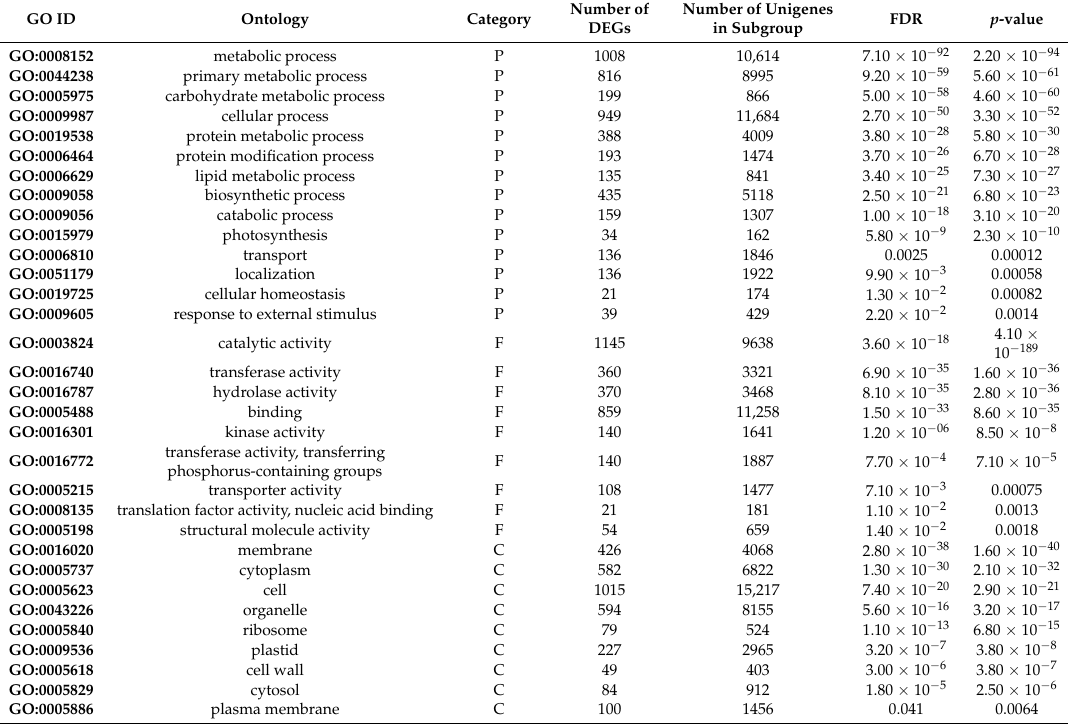
Table 3. Gene ontology (GO) functional enrichment analysis of differentially expressed genes in CBCVd infected